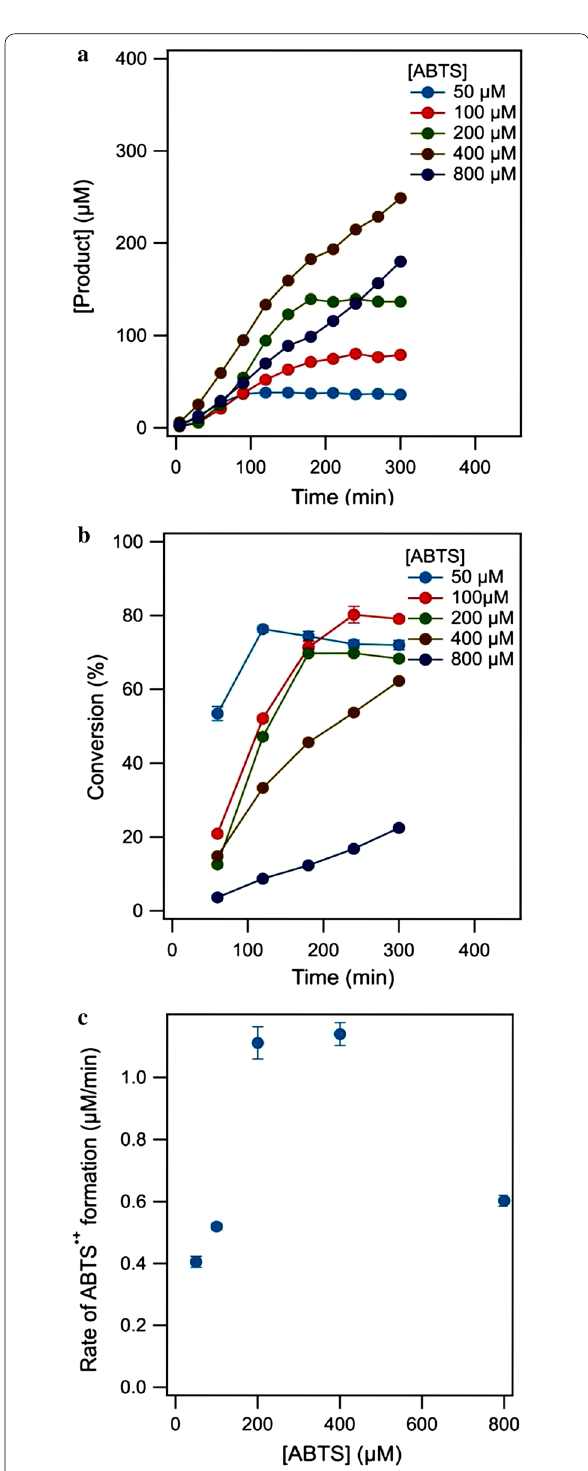
Fig. 5 The effect of ABTS concentration on ABTS • + production ( a ), the conversion of ABTS ( b ), and the rate of product formation ( c ) by DMELC (temperature, 30 °C, shaking speed, 180 rpm, pH, 5.8, 2.0 mg laccase)